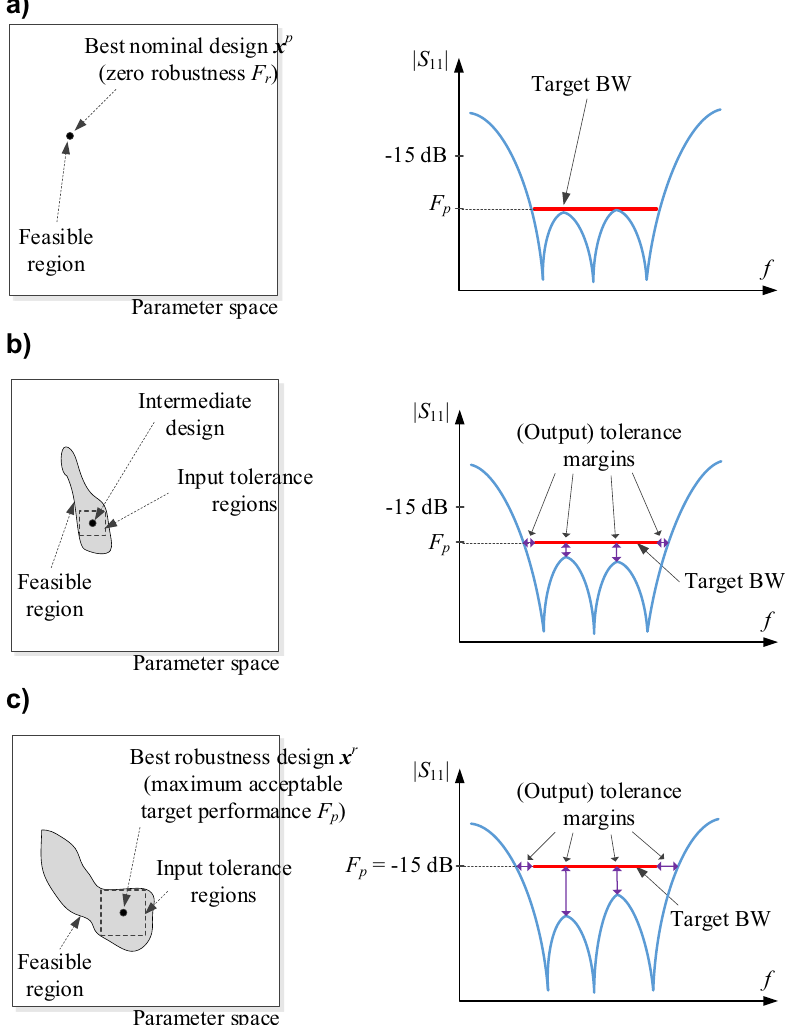
Figure 1. Multi-criterial microwave design with robustness evaluation. Gray manifold indicates the feasible region encompassing the vectors for which, for a given F p , the specifications are met (the feasible region is enlarged for the relaxed F p ). The right panels show reflection responses at exemplary designs of a broadband filter for various values of the assumed nominal objective F p : ( a ) the highest-quality nominal design x p ; here, the feasible manifold only consists the design x p itself, consequently, the input tolerance equals 0; ( b ) intermittent design: larger feasible region with the maximum robustness point residing in the centre; (c) the most robust design (for which acceptable value of F p is the highest, for example, − 15 dB for in-band filter characteristic): the input tolerance values are maximum when centering the design. The design set rendered for various F p constitute a Pareto set comprising the best robustness vs. performance